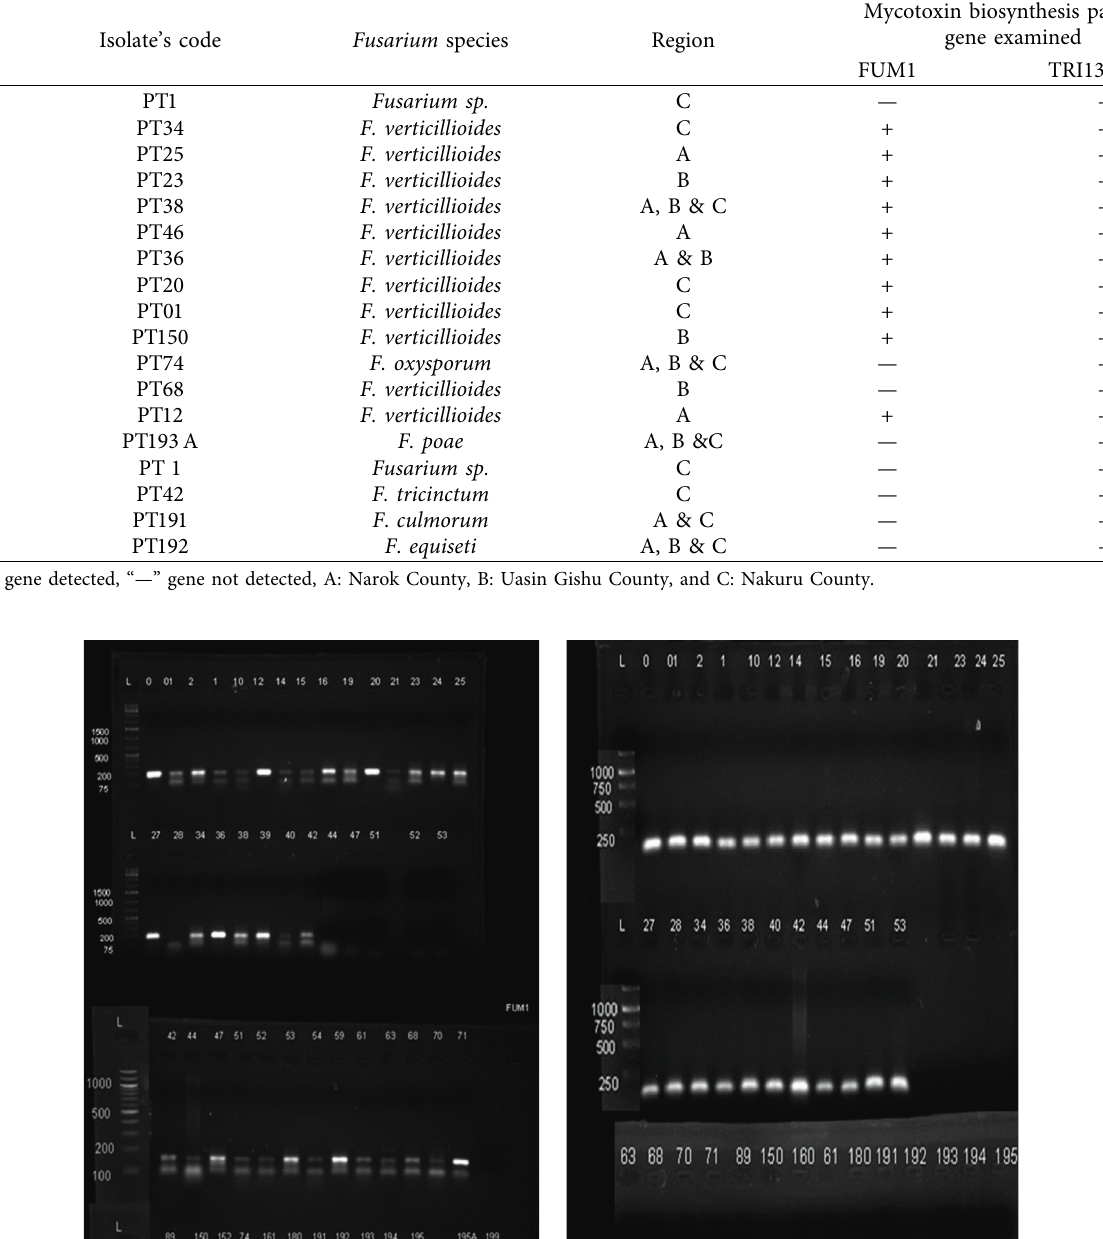
Table 2: Mycotoxigenic potential of Fusarium spp. isolated from grains of wheat genotypes in Narok, Uasin Gishu, and Nakuru Counties in Kenya.